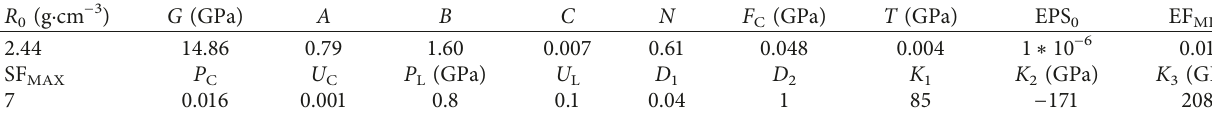
Table 1: Rock material parameter.